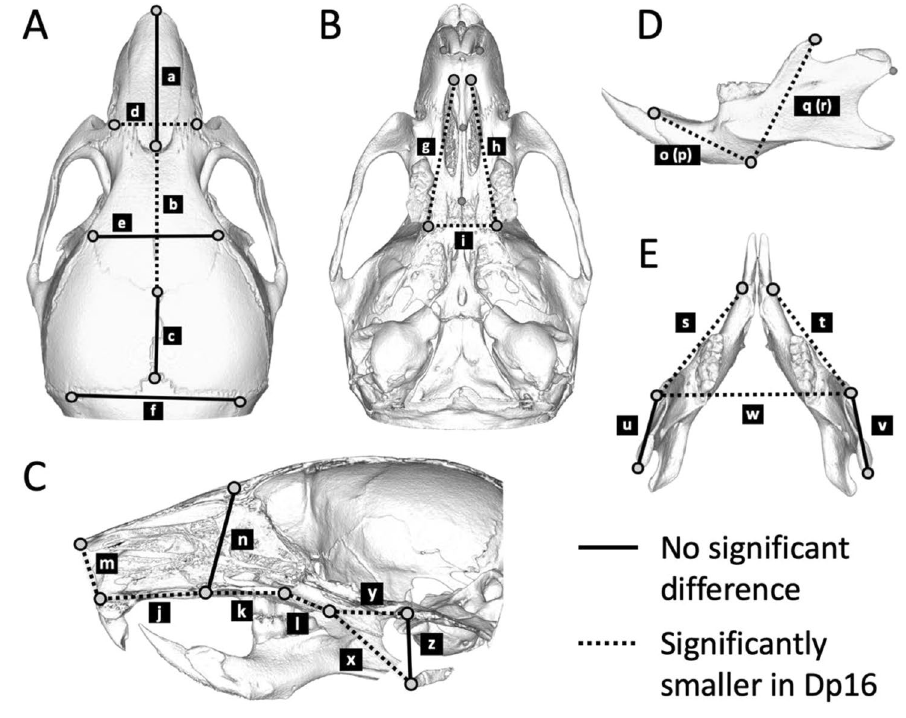
Figure 2. Comparison of craniofacial measurements and the hyoid position. The dorsal ( A ), ventral ( B ) and sagittal ( C ) views of the cranium and the lateral ( D ) and dorsal ( E ) views of the mandible are shown. Solid lines indicate linear distances that are similar between genotypes, while dotted lines represent those significantly smaller in Dp16 mice than WT mice. Values and statistics are summarized in Table